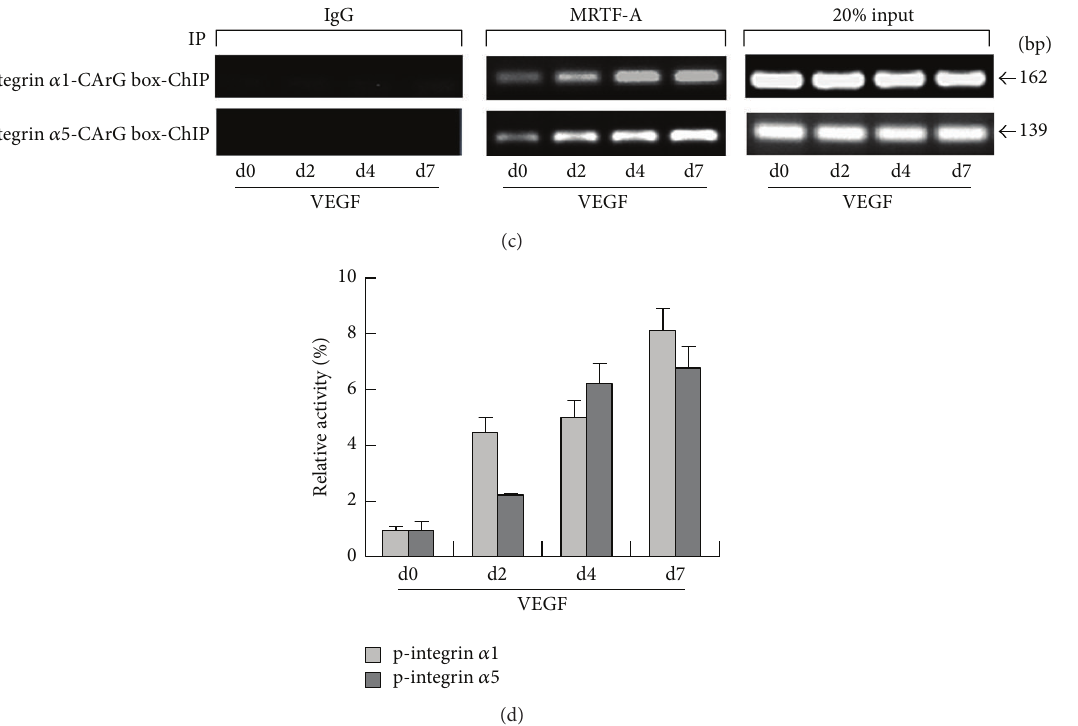
Figure 3: MRTF-A activates the transcription of integrins 𝛼 1 and 𝛼 5 by binding to the CArG box with their promoters. (a and b) Luciferase assays were performed 24 h after transfection of MRTF-A and integrin 𝛼 1/integrin 𝛼 5 promoter-luc plasmids into MSCs, COS-7 cells and HUVECs. ∗ 𝑃 < 0.05 ; ∗∗ 𝑃 < 0.01 , 𝑛 = 3 . (c and d) ChIP assays were performed in MSCs treated with VEGF at d2, d4, and d7. Cross-linked chromatin was immunoprecipitated with specific anti-MRTF-A antibody. The precipitated chromatin DNA was then purified and amplified by reverse transcription PCR (c) and real time PCR (d) with specific primers that spanned CArG boxes in integrin promoters. The negative control in the immune-precipitation was performed with IgG